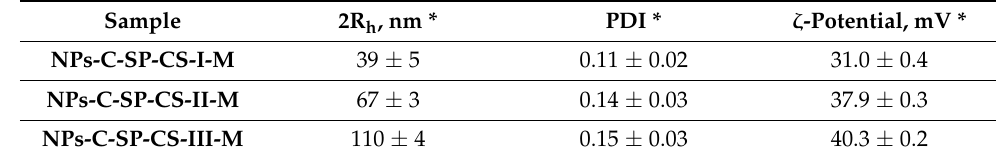
Table 6. Characteristics of the nanoparticles prepared by ionic gelation method. Sample